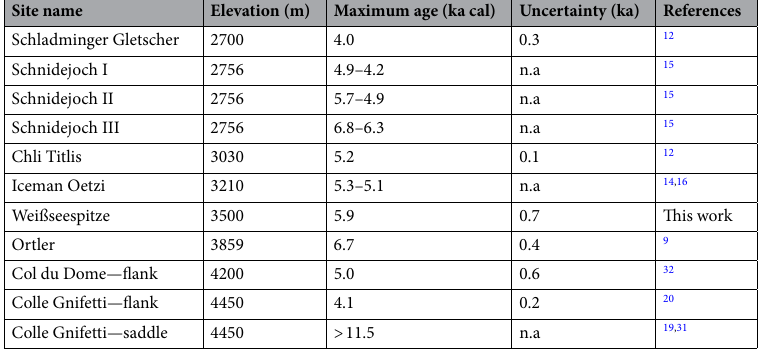
Table 2. Compilation of glacier maximum age constraints.